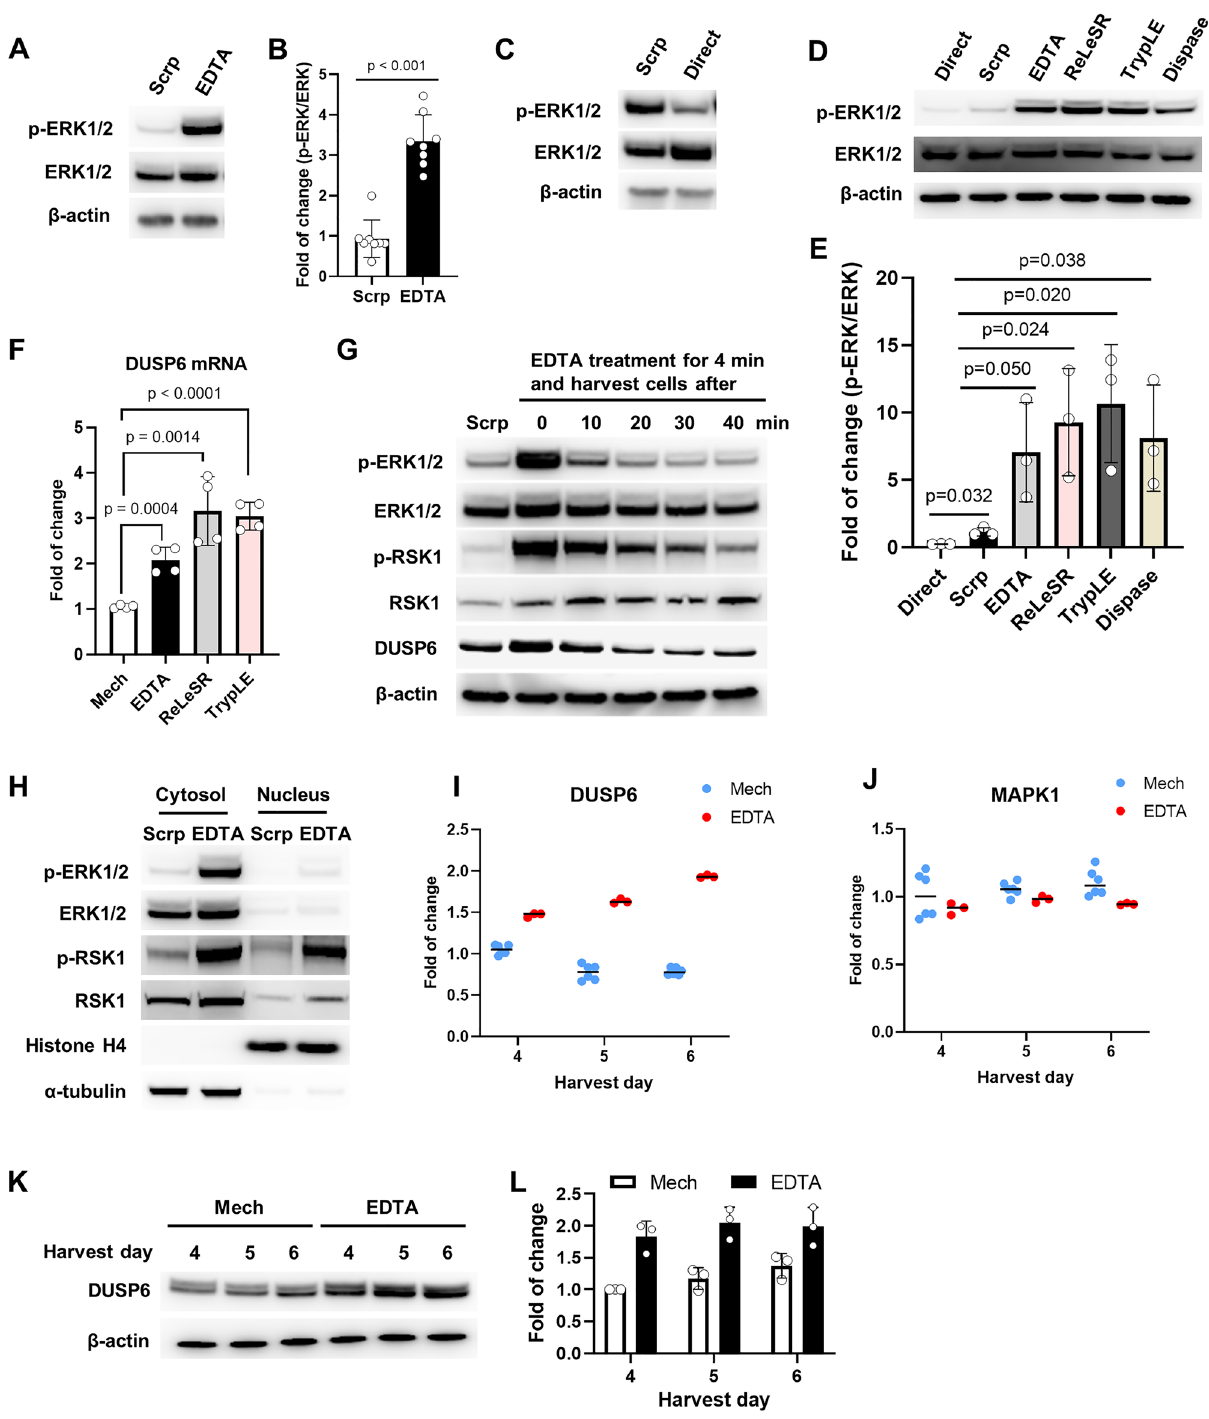
Figure 2. ERK phosphorylation following EDTA-induced cell dissociation in hiPSCs. ( A ) hFSiPS1 cells were harvested using a scraper (Scrp) or EDTA and phosphorylated ERK (p-ERK) levels were analyzed. Cells were treated with EDTA for 4 min before harvesting. ( B ) p-ERK to ERK ratio was calculated (n = 8). ( C ) p-ERK levels in cells harvested using a scrapper (Scrp) and cells that were directly lysed (Direct) on culture dishes. For direct lysis, cells were washed with DPBS twice and lysed using the lysis buffer containing phosphatase inhibitors. ( D ) p-ERK levels in cells harvested by Direct, Scrp, EDTA, ReLeSR, TrypLE and Dispase. ( E ) Quantification of p-ERK levels (n = 3). ( F ) Expression of DUSP6 mRNA was analyzed using real-time PCR after cells were passaged thrice using the mechanical method, EDTA method, ReLeSR, or TrypLE. ( G ) Time course showing the levels of p-ERK, phosphorylated RSK1 (p-RSK1), and DUSP6 following 4 min of EDTA treatment. After the treatment, EDTA solution was removed and cells were washed with DPBS. Cells remained in DPBS until harvest at indicated time points. (H) Analysis of nuclear translocation of p-ERK and p-RSK1 following EDTA treatment. Cells were harvested after 4 min of EDTA treatment and washed with DPBS. Nuclear and cytosolic fractions were isolated. Histone H4 was used as the nucleus indicator; α-tubulin was used as the cytosol indicator. (I) Cells were harvested on indicated day after mechanical or chemical passaging. DUSP6 expression was analyzed using real-time PCR. (J) MAPK1 was used as a control for both passaging methods. (K) DUSP6 protein levels in cells harvested on indicated day after mechanical or chemical passaging. (I) Quantification of DUSP6 protein (n =